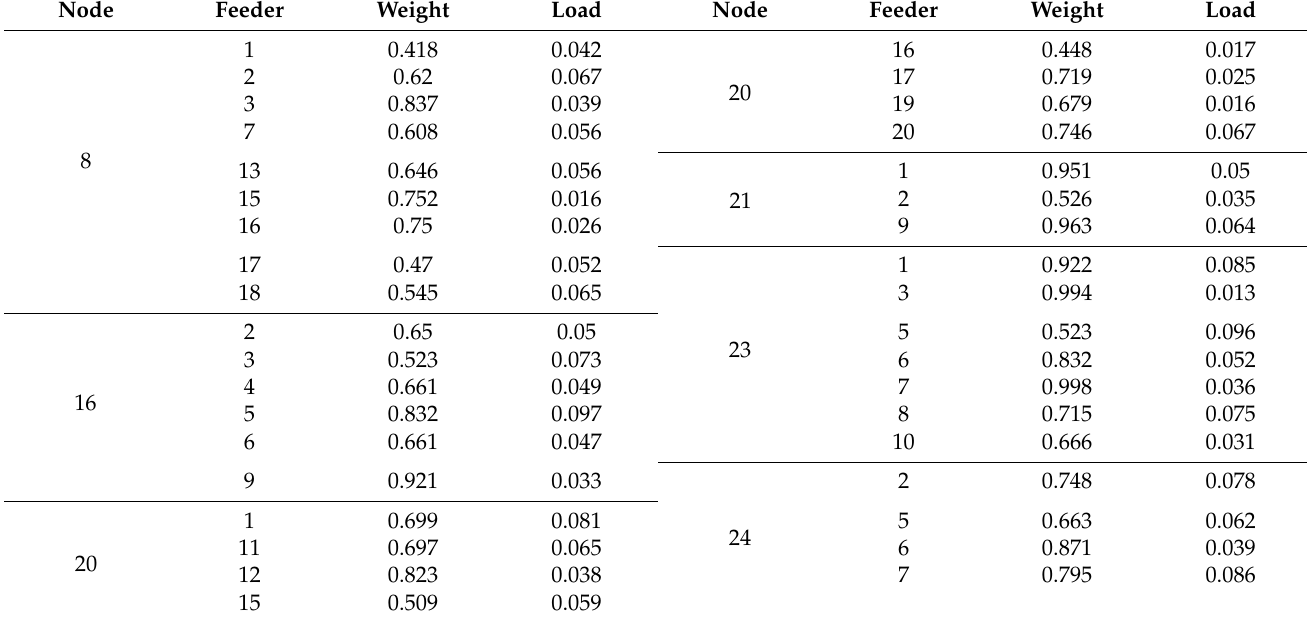
Table 6. Feeder load